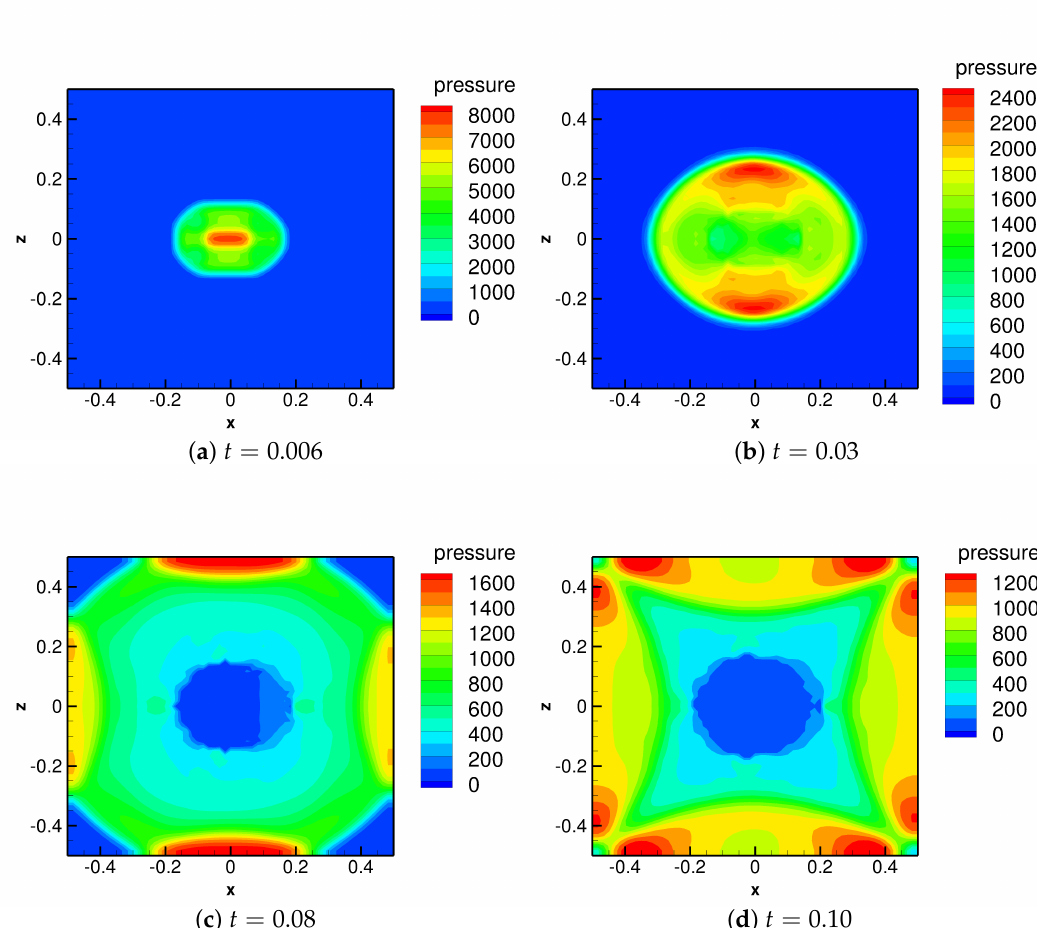
Figure 8. The temporal evolution of the pressure field for an initially cuboidal bubble in slice plots ( y =